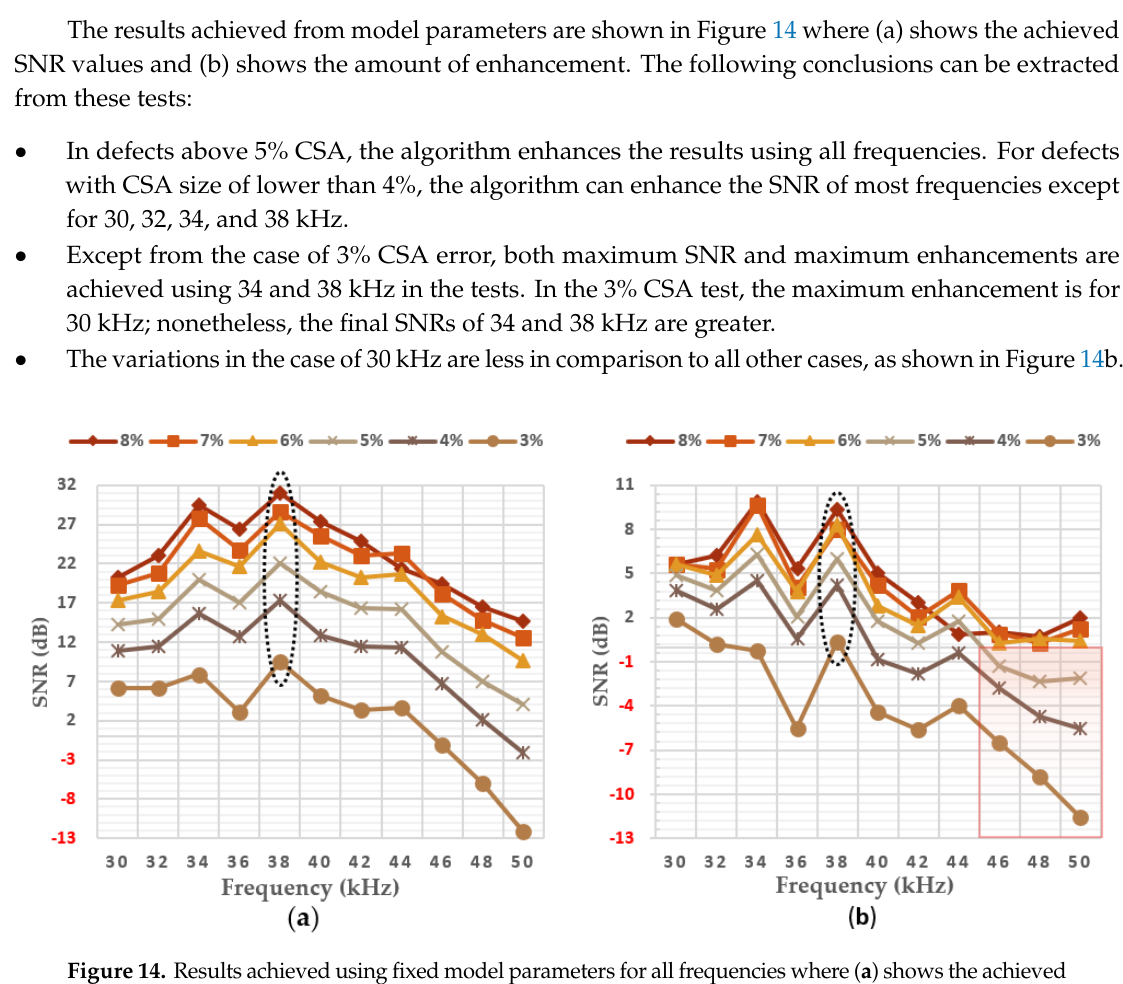
Figure 14. Results achieved using fixed model parameters for all frequencies where ( a ) shows the achieved SNR and ( b ) shows the amount of improvement in comparison to the general propagation